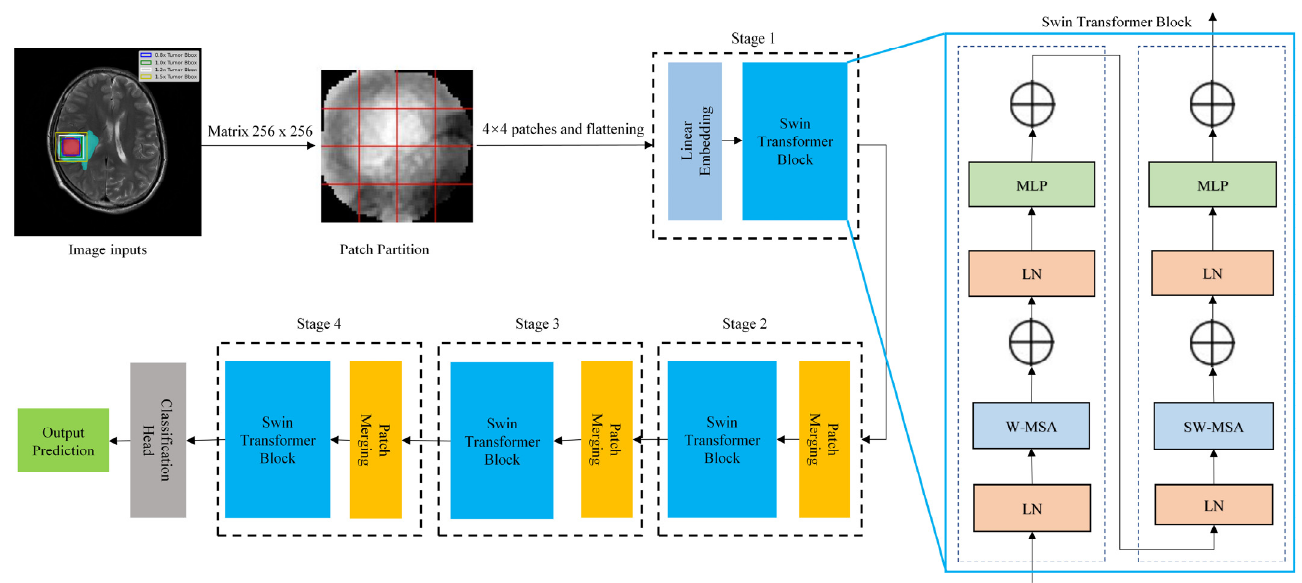
Figure 4. The entire classification process and Swin Transformer architecture. LN: layer normalization; MLP: multilayer perceptron; W-MSA: window multi-head self-attention; SW-MSA: shifted-window multi-head self-attention.